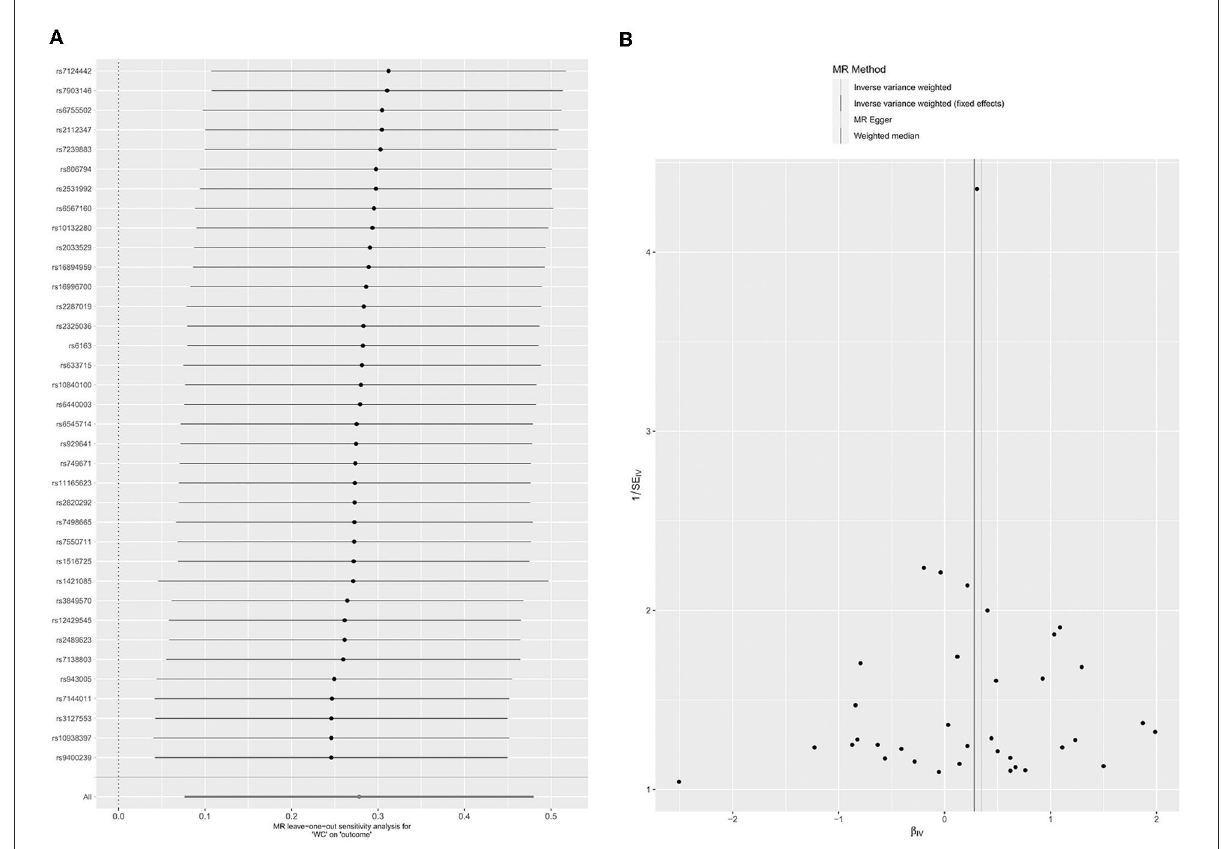
FIGURE5 Leave-one-out permutation analysis plot (A) and Funnel plot of (B) of WC.